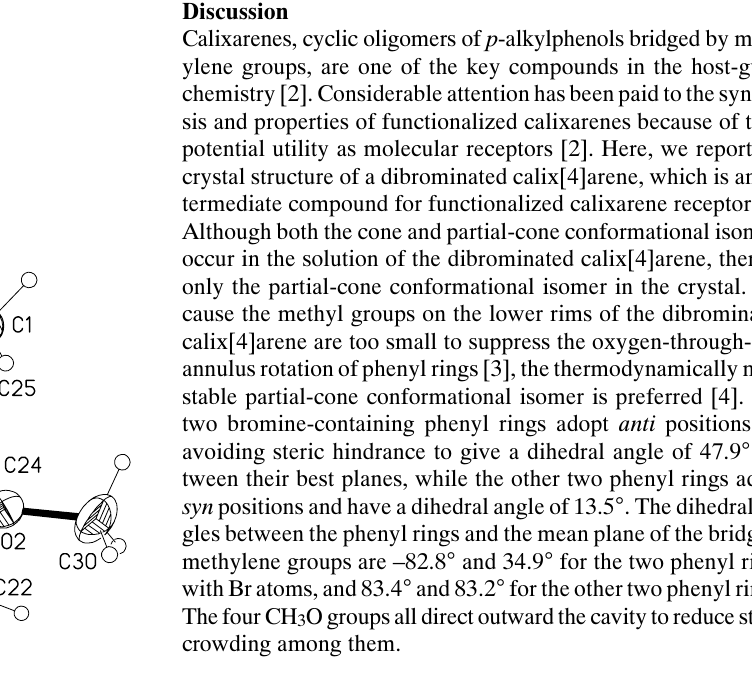
Table 1. Data collection and handling.